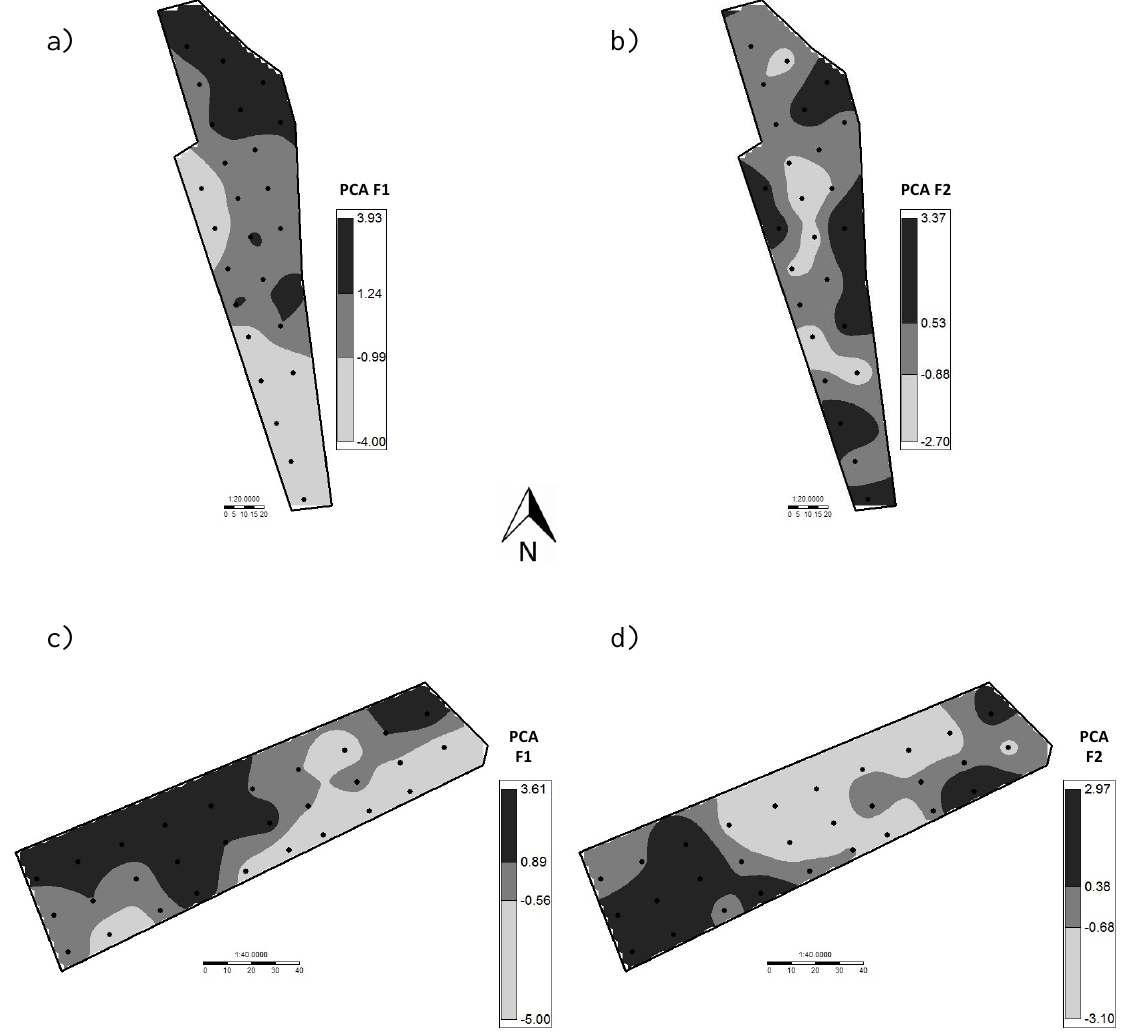
Figure 6. Map of the two first components of each principal component analysis (PCA) for slope ( a , b ), and for flat ( c , d ) plot. ( a , c ) Component 1; ( b , d ) component 2. Each class (grayscale) corresponds to 33% of the data. F1 = PC 1 and F2 = PC 2.